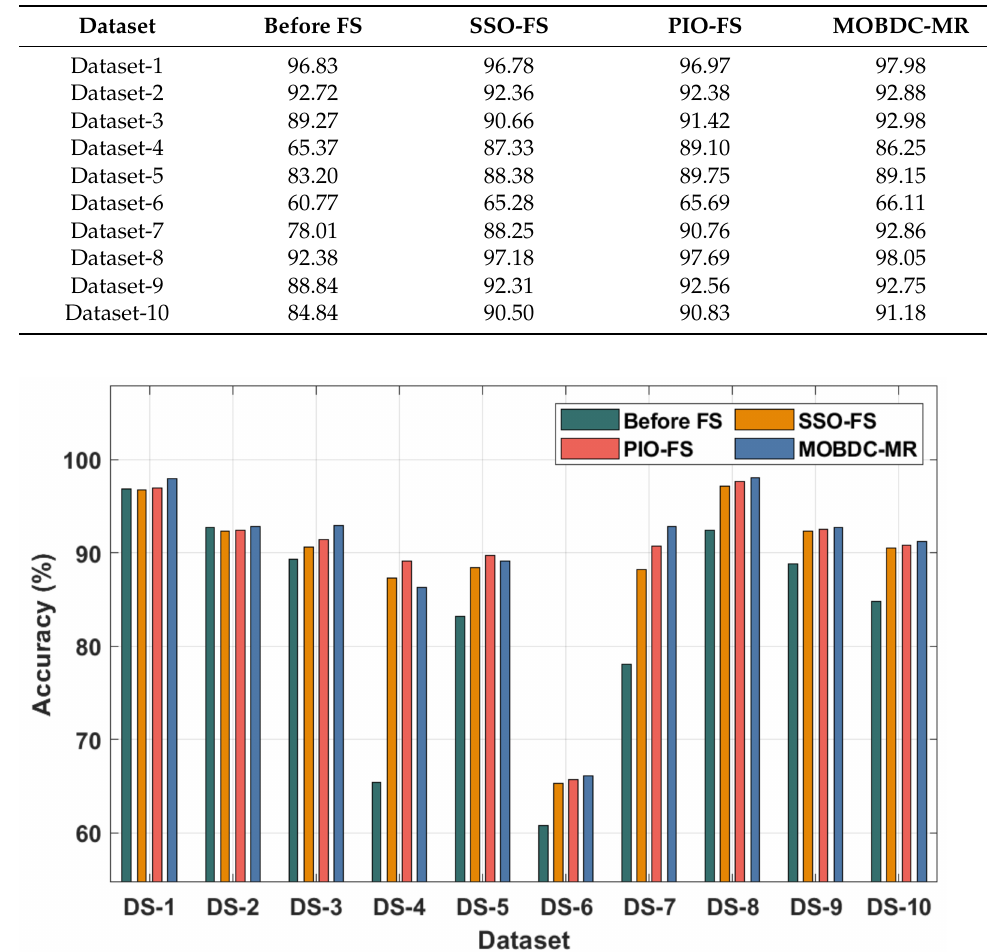
Figure 5. Accuracy analysis of the MOBDC-MR